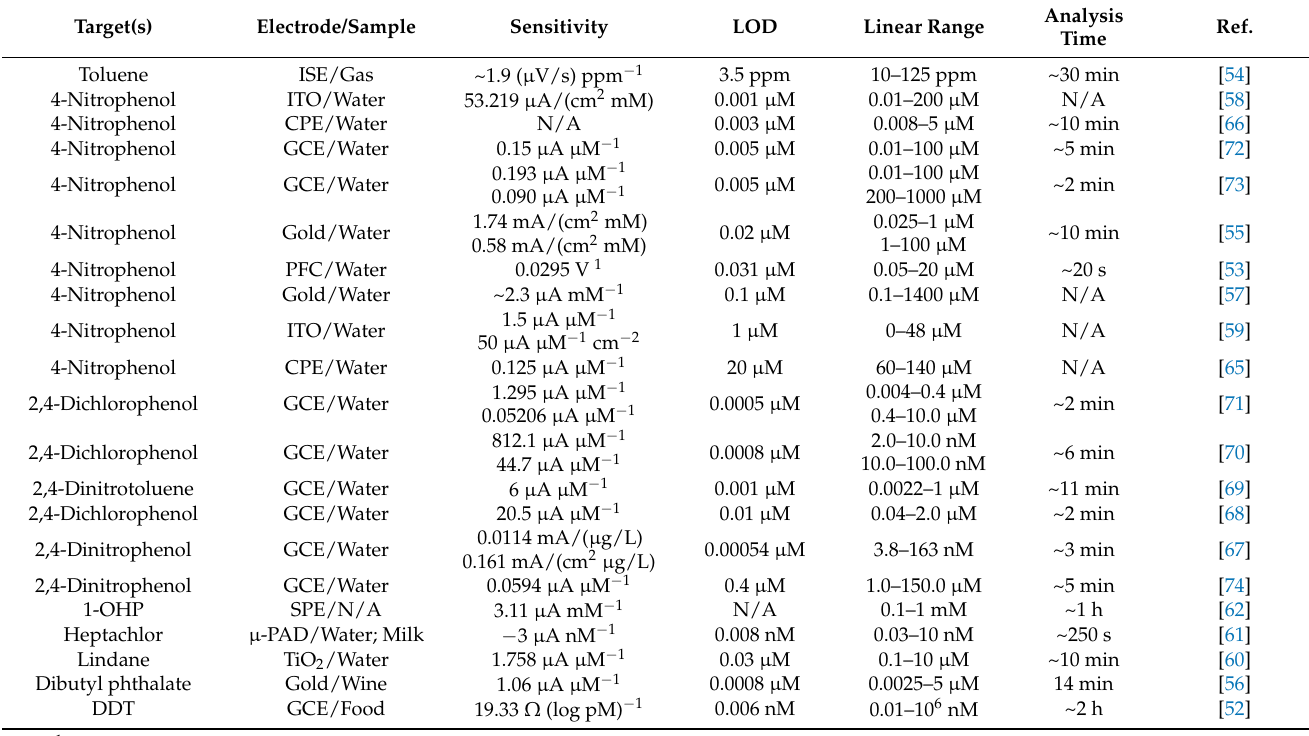
Table 2. Analytical characteristics of developed MIP-based electrochemical sensors for EPA Priority Pollutants. The rows of the table are arranged based on the analytes and